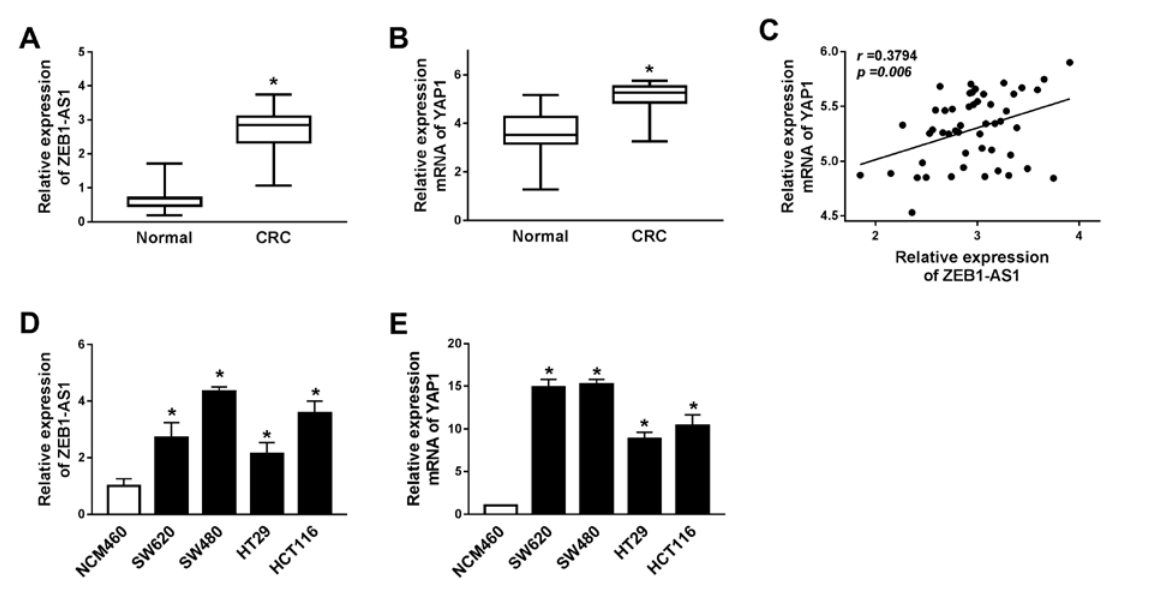
Figure 1: The expression level of ZEB1-AS1 and YAP1 was up-regulated in human colorectal cancer (A) ZEB1-AS1 mRNA level in CRC patients (n=50). (B) The mRNA level of YAP1 in CRC patients (n=50). (C) The correlation between ZEB1-AS1 and YAP1 in CRC patients (n=50). (D-E) ZEB1-AS1 (D) and YAP1 (E) expression in normal human colon mucosal epithelial cell line NCM460 and human colorectal cancer cell lines SW620, SW480, HT29 and HCT116. * means p <